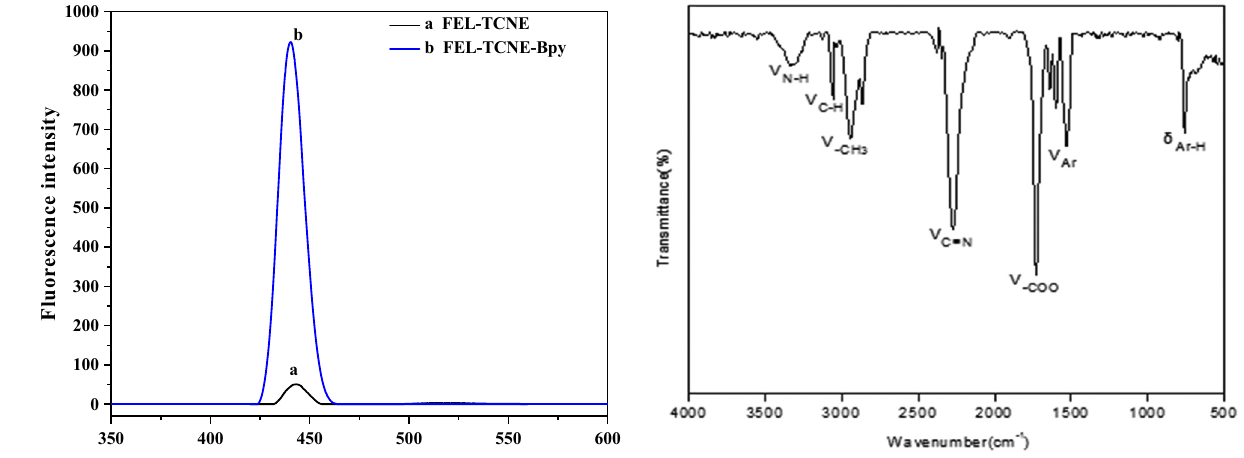
Figure 1: FEL – tetracyanovinyl fl uorescence spectra of FEL – tetracyanovinyl – Bpy system UV spectrum.